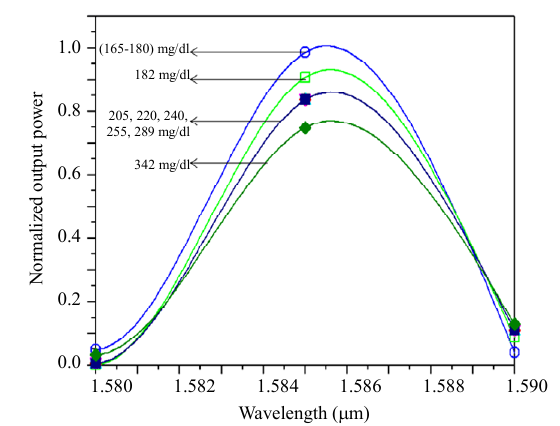
Fig. 7 Normalized output power for different glucose concentrations in urine.